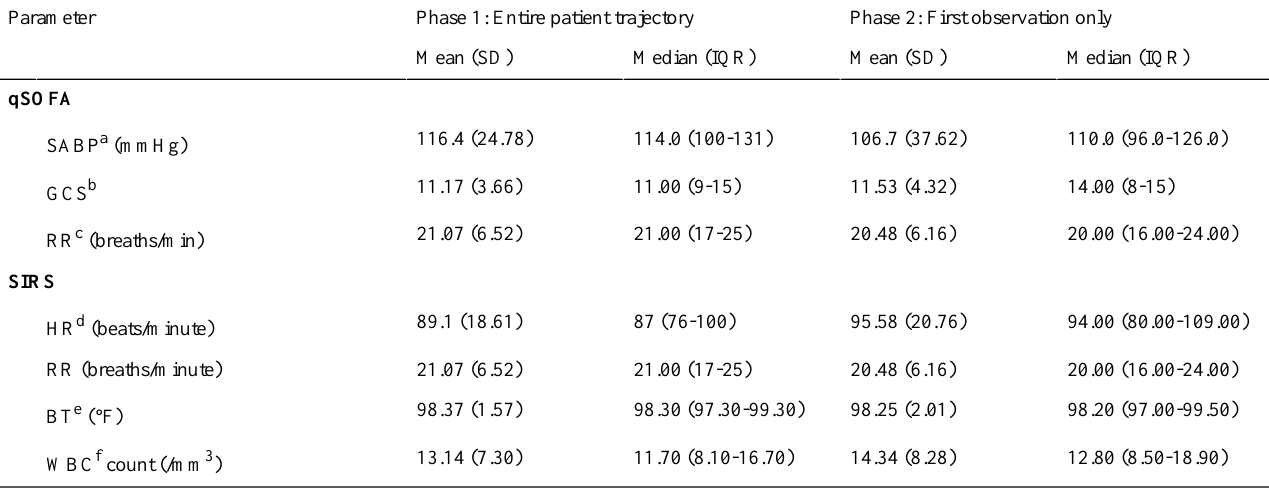
Table 3. Statistical distributions of parameters for quick Sequential Organ Failure Assessment (qSOFA) and systemic inflammatory response syndrome (SIRS).